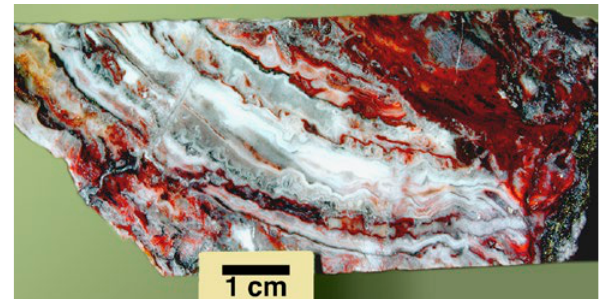
Figure 44. Contemporaneous veining and re-mobilisation of col- loform quartz banding occurs in core from the New Cobar Mine, NSW. Three sets of quartz veinlets in the centre bands cut each other and one of them parallels and merges into a colloform layer. Cleaner ‘cloudy’ white quartz welling out as an expanded band and cutting other colloform layers and the irregular wisps of ‘poured in’ quartz in the upper core confirm the mobility of the newly deposi- ted silica.